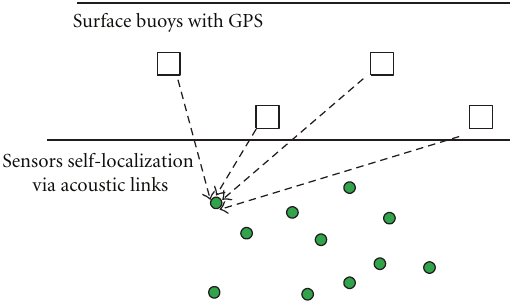
Figure 1: An underwater sensor network with multiple surface buoys.